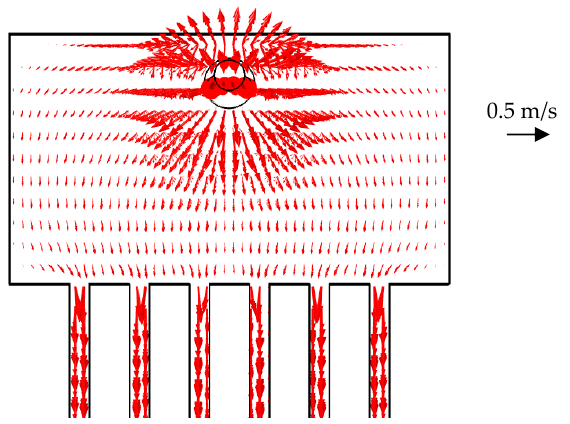
Figure 8. Trajectory of the fluid in the collector and respective distribution to the channels at a fluid flow of 100 mL/min and at a scale of 5.